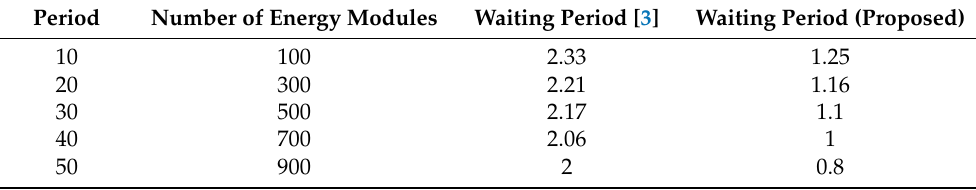
Table 5. Energy modules with waiting periods.